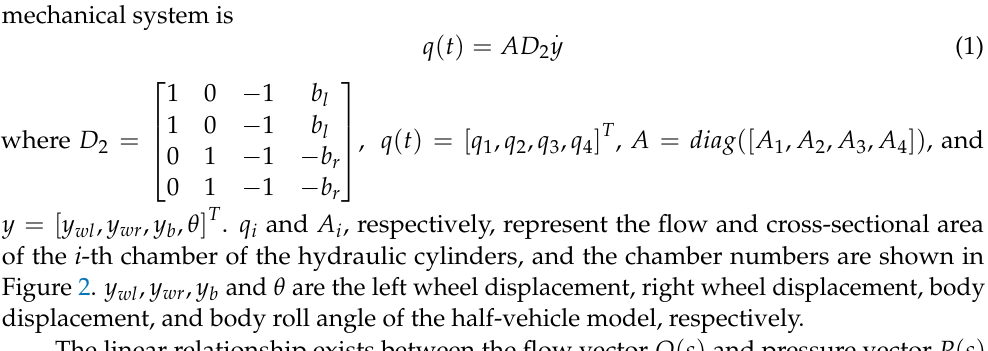
Figure 3. Schematic of the HIIRS system ( v1 — Check valves; la — low-pressure accumulator; ha — high-pressure accumulator; v2 — accumulator valve; x , 𝑥′ — state nodes). Table 1. The SUV parameters used in the mechanical subsystem.